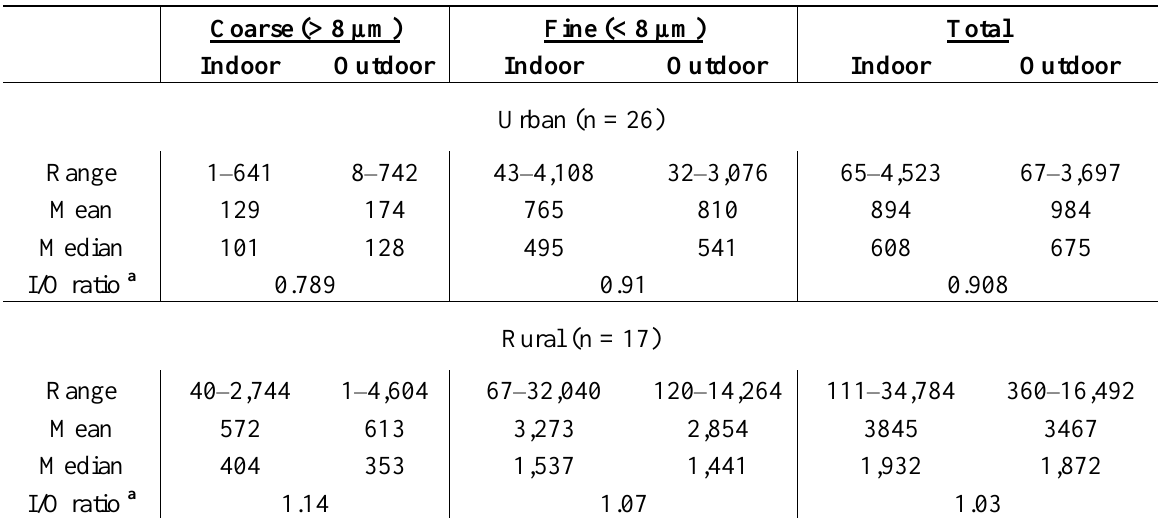
Table 2. Indoor and outdoor range, mean and median fungal concentrations (colony forming units per cubic meter of air), and Indoor/Outdoor ratio for coarse, fine, and total organism